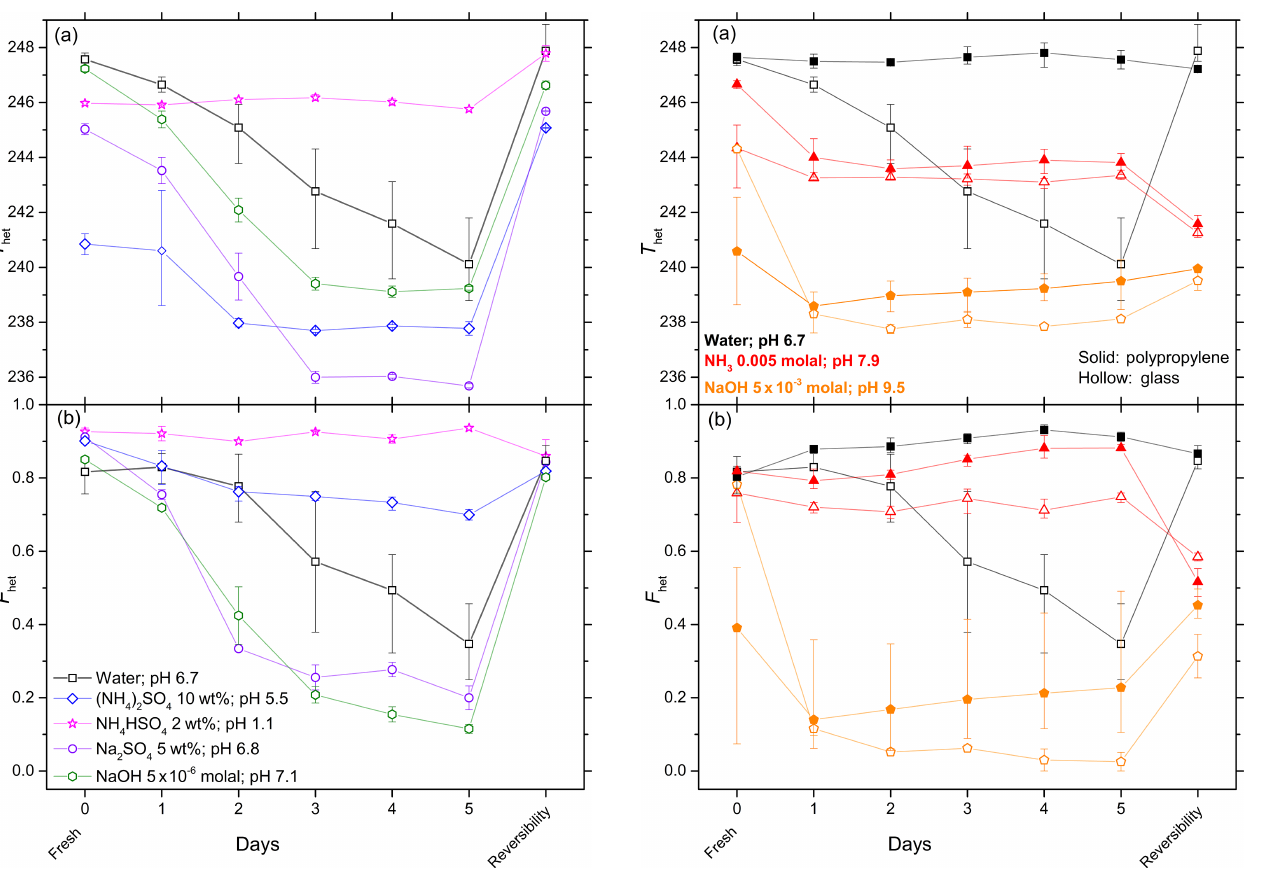
Figure 5. Development of T het (a) and F het (b) for 5 wt% SA quartz suspended in water, ( NH 4 ) 2 SO 4 solution (10 wt%), NH 4 HSO 4 solution (2wt%), Na 2 SO 4 solution (5wt%) and NaOH solution (5 × 10 − 6 molal) over a period of 5 days. All suspensions were pre- pared and aged in borosilicate glass vials. After 5 days of aging the reversibility was tested: the suspensions were centrifuged, the supernatant decanted, the aged particles washed several times with pure water, resuspended in pure water, and subjected to an emul- sion freezing experiment. All data points are means of at least two separately aged suspensions. The error bars show representative ex- perimental variations (min to max).